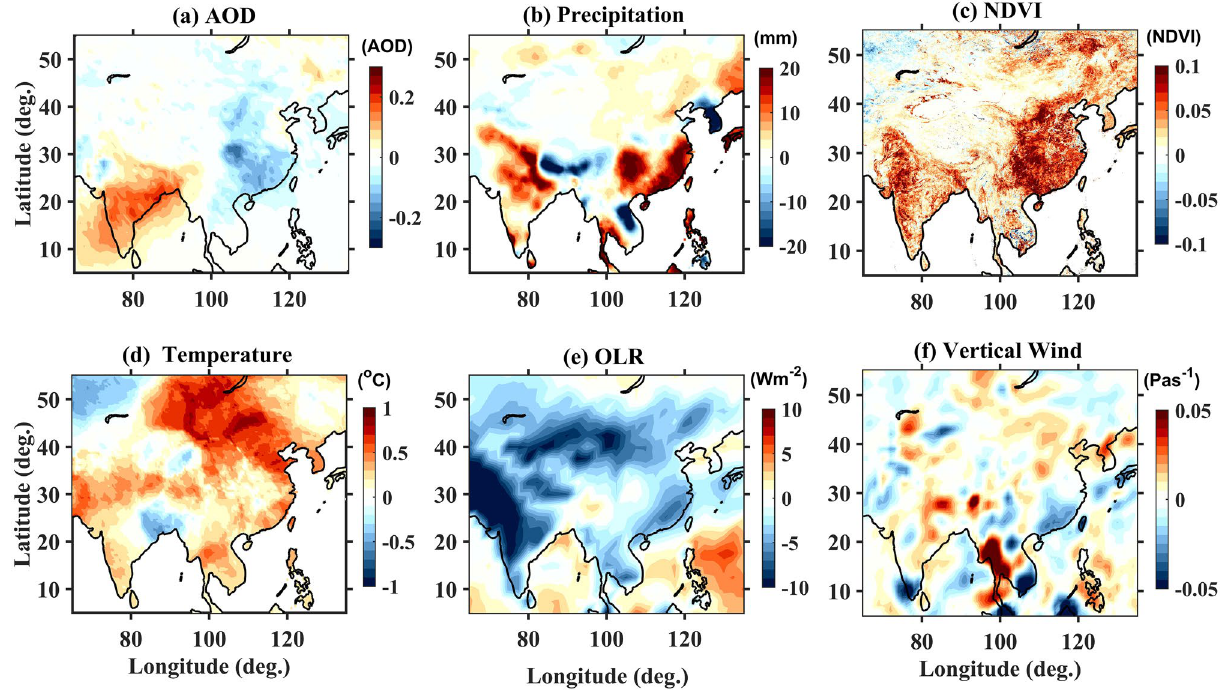
Figure 3. The 5-year ensemble mean difference (2014–2018 minus 2001–2005) observed in ( a ) AOD, ( b ) Precipitation, ( c ) NDVI, ( d ) Surface temperature, ( e ) OLR and ( f ) Pressure vertical velocity at 500 hPa. AOD and NDVI are obtained from MODIS, precipitation and surface temperature from CRU, OLR is taken from NOAA and pressure vertical velocity from ERA-Interim reanalysis data. The maps were created by using MATLAB software R2019b with mapping tool box (see https ://in.mathw orks.com/produ cts/new_produ cts/relea se201 9b.html and https ://www.mathw orks.com/produ cts/mappi